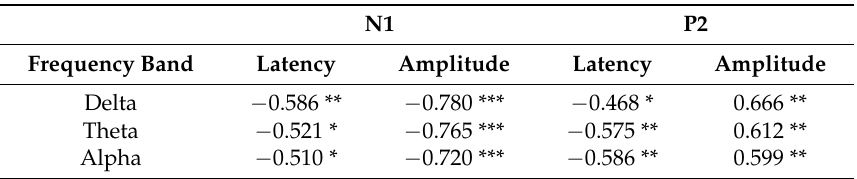
Table 1. Correlation coefficients for relationship between-phase locking values and N1 and P2 latency and amplitude values in response to the CV syllable /bu/ at electrode Cz as reported in Koerner and Zhang